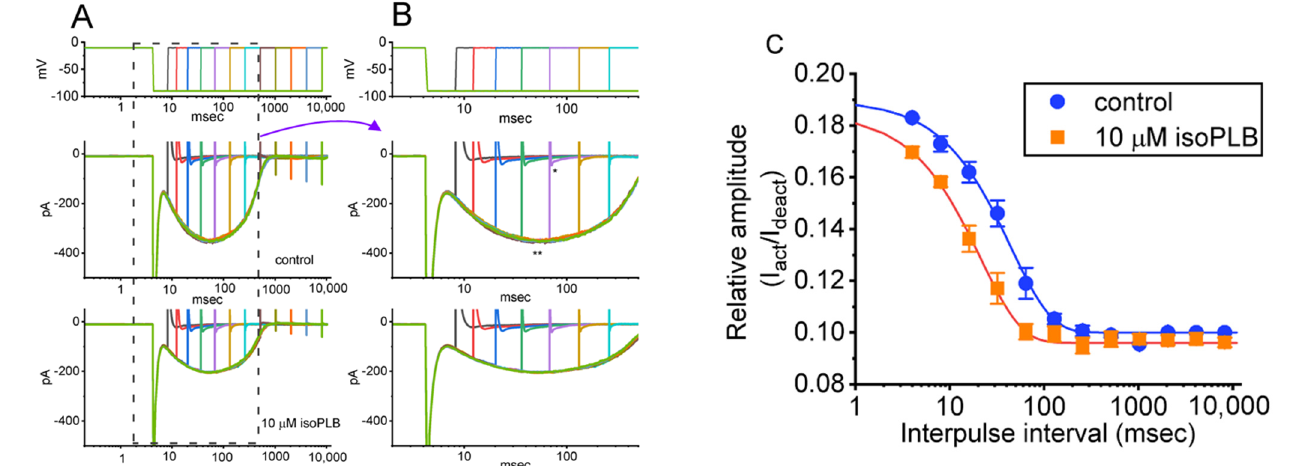
Figure 5. IsoPLB-mediated changes in I K(erg) magnitude evoked by the envelope-of-tail test. Cells were bathed in a high-K + , Ca 2+ -free solution and we then filled the pipette with a K + -enriched solution. Inward deactivating and activating currents were evoked by 4-ms to 8.192-s step hyperpolarizations to − 90 mV with a geometric progression from a holding potential of − 10 mV. ( A ) Representative potential and current traces evoked by the envelope-of-tail test. In ( B ), potential and current traces are the expanded records from the dashed box in ( A ). Of note, the x axis for the potential and current tracings appearing in ( A , B ) is scaled with a geometric progression. * indicates the I act of hyperpolarization-evoked I K(erg) and ** indicates the I deact of the current. The uppermost part in ( A , B ) shows the voltage-clamp protocol delivered. ( C ) Relationship of the relative amplitude versus pulse duration obtained with or without the application of 10 μ M isoPLB (mean ± SEM; n = 7 for each point). The relative amplitude appearing at the y axis was measured, when the inwardly decaying current (i.e., I act ) following return to − 10 mV was divided by peak I K(erg) (i.e., I deact ) in response to membrane hyperpolarizing pulses with varying pulses in a geometric progression. Of note, the relationship is illustrated with a semi-logarithmic plot. The smooth curve without or with the addition of 10 μ M isoPLB indicates the best fit to single exponential function with a time constant of 44.3 or 21.2 msec, respectively. The decaying rate of I K(erg) evoked during the envelope-of-tail occurred in single exponential function, and the presence of isoPLB yielded an increase in the decay rate of I K(erg) evoked upon such envelope-of-tail test.